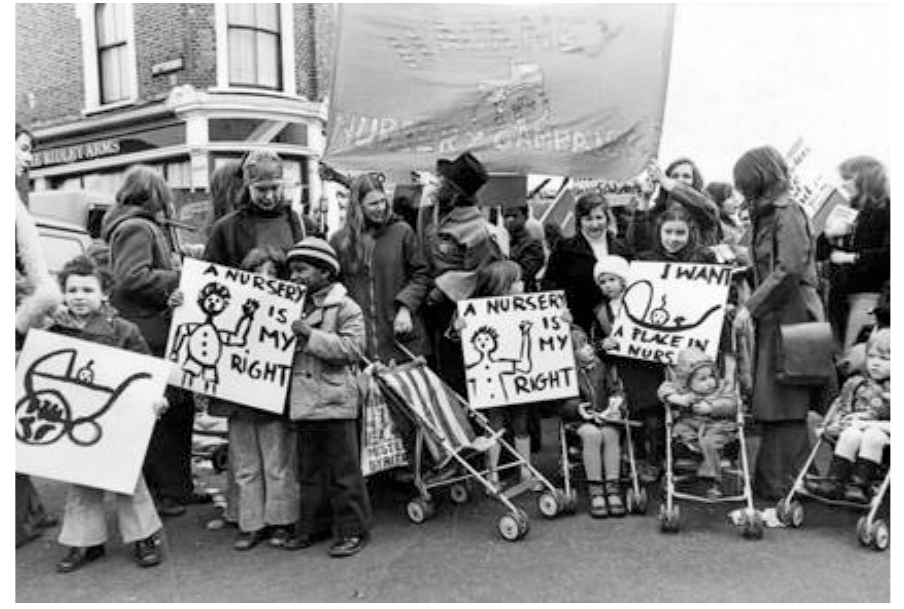
Figure 4: Hackney Flashers 1978, Beyond the Family Album and Other projects Belfast Exposed Archive 2005 The explicit connection made by Hackney Flashers between women’s work and